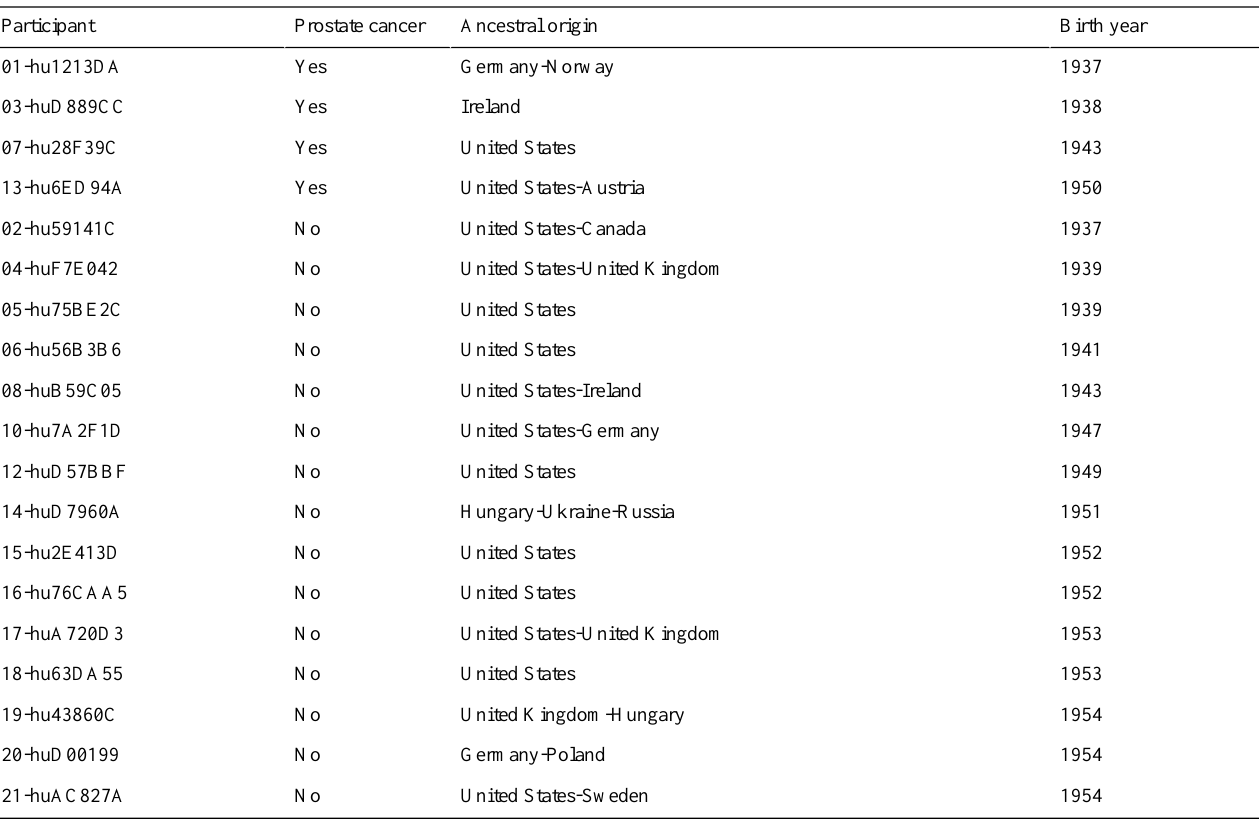
Table 3. Characteristics of genomic data